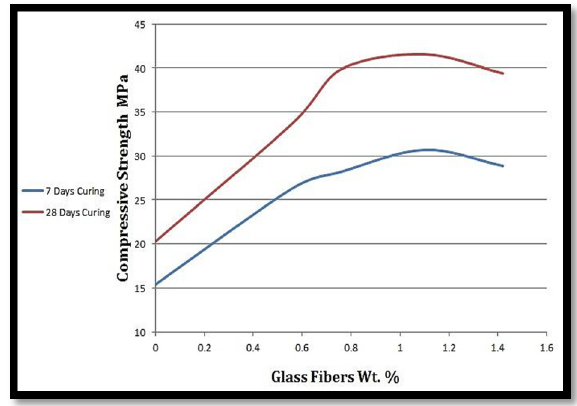
Fig. 11. Effect of layers glass fibers addition with